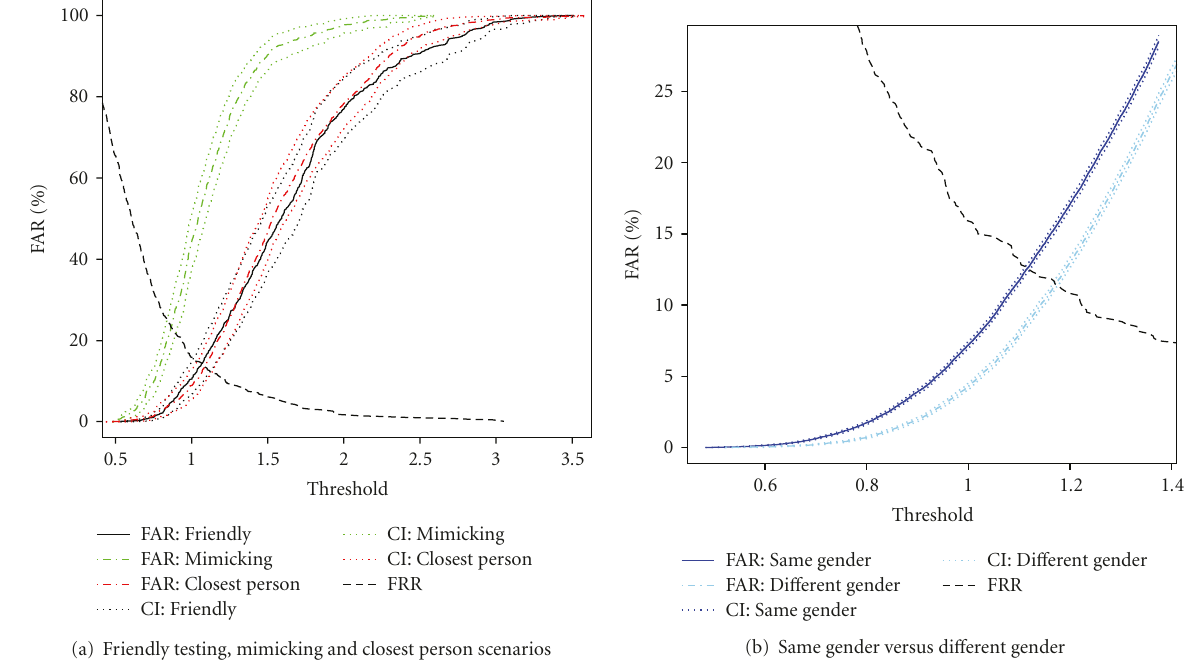
Figure 7: Security assessment in terms of FAR